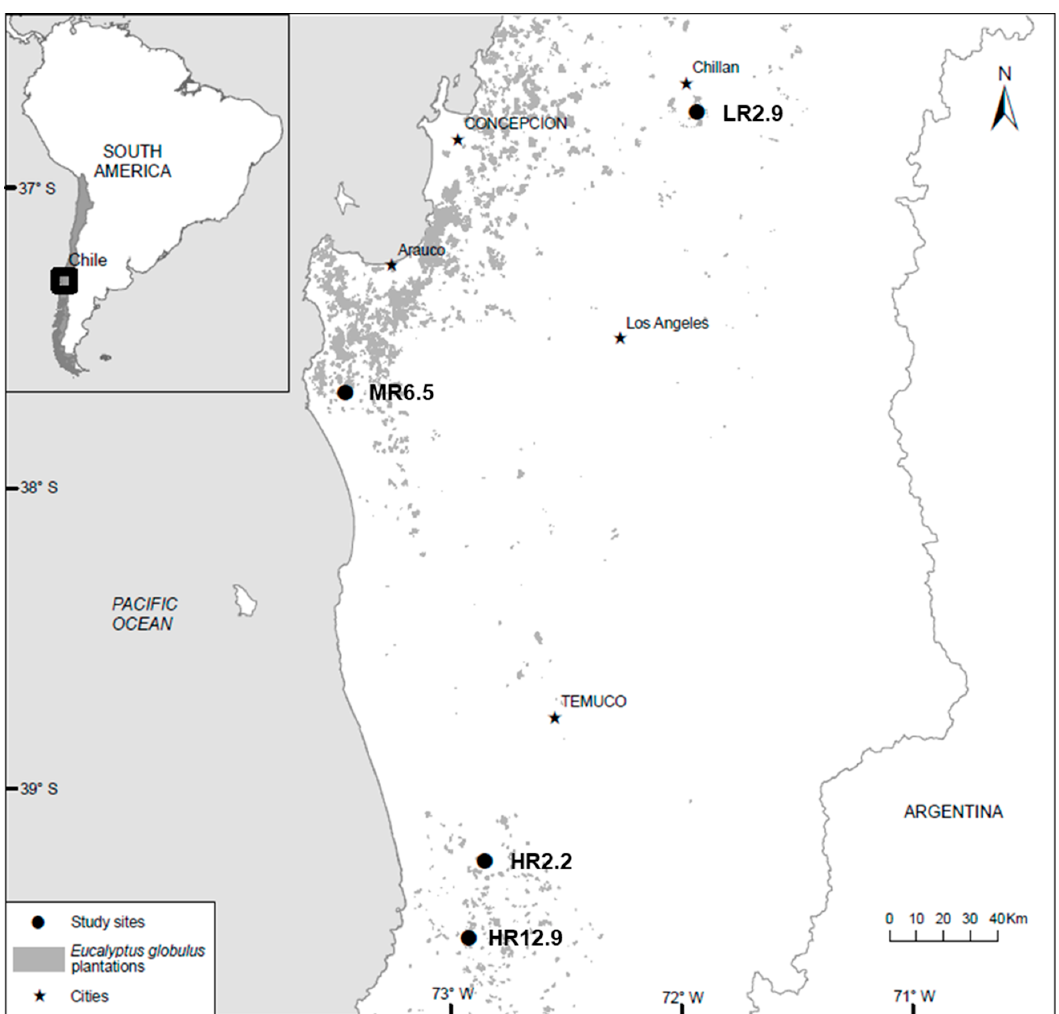
Figure 1. Location of sites used in this study for E. globulus in Chile. Table 1. Mean annual rainfall (Rain), mean annual maximum temperature (Tmax), mean annual minimum temperature (Tmin), clay content (Clay), and organic matter (OM), in the first 20 cm of soil depth for each site.